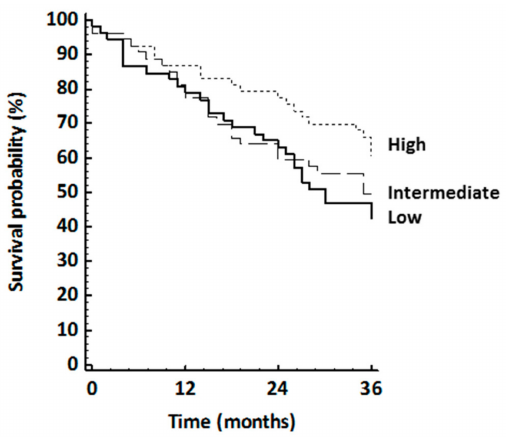
Figure 2. Kaplan–Meier curve showing the rate of hospitalization or death 36 to 72 months after enrolment as a function of walking speed